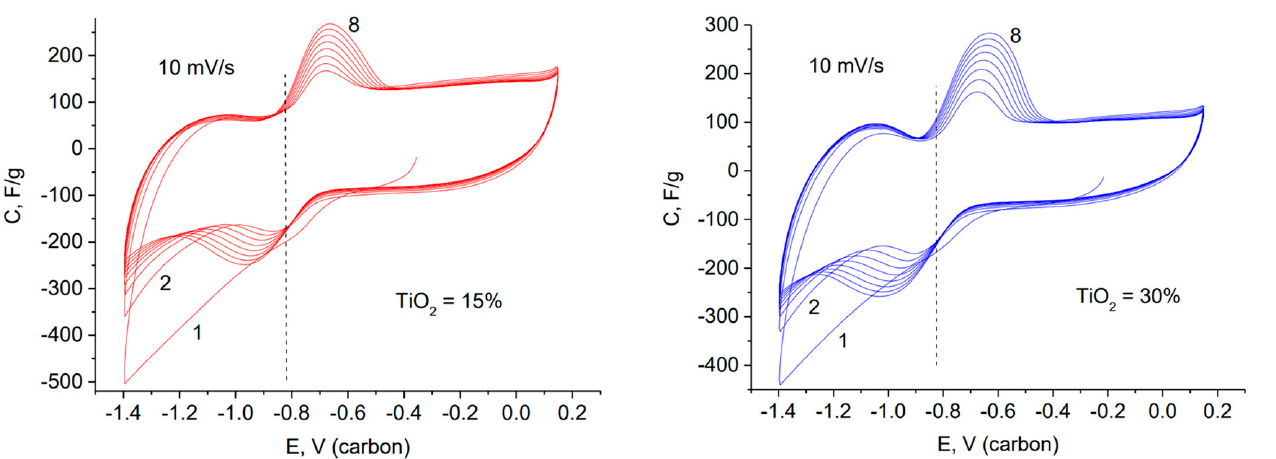
10 of 19 Table 2. Main characteristics of porous structure of the rGO/TiO 2 composite. Hydrophilic Porosity~~~ cm 3 /g